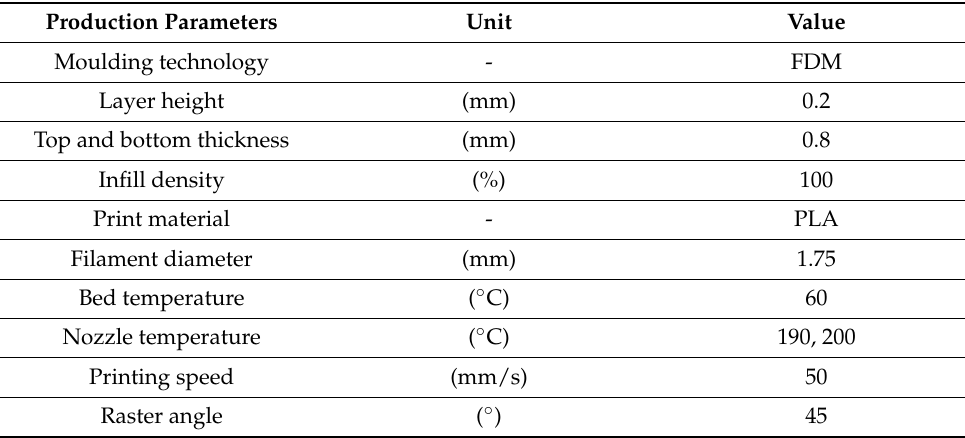
Table 2. Production